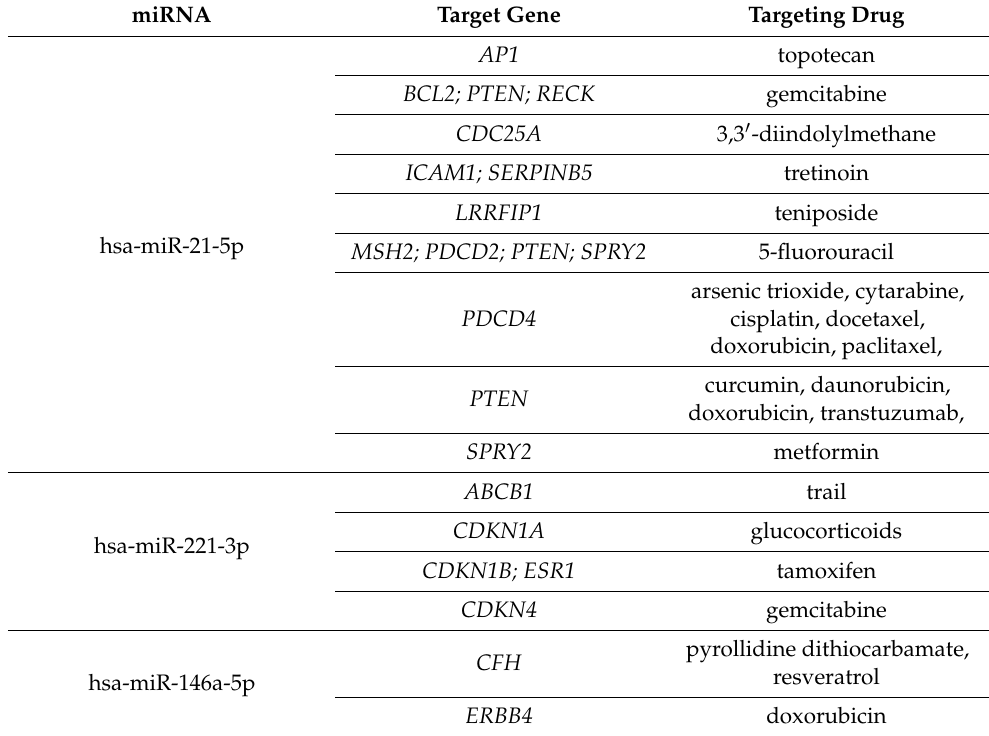
Table 6. Drug interaction